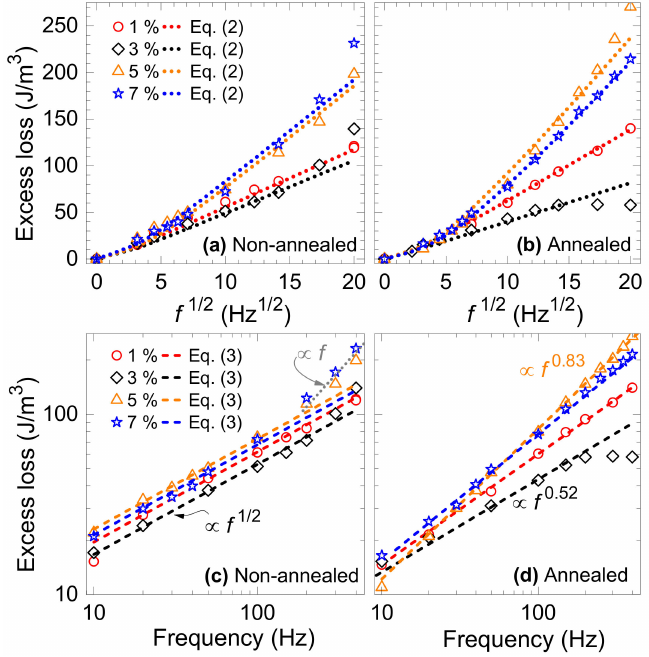
Figure 11. Excess loss in ( a , c ) non-annealed and in ( b , d ) annealed electrical steels of different cutting clearance. Experimentally obtained loss (points) are compared with its theoretical predictions represented by dotted lines calculated through Equation (2) in case of ( a , b ) and by short-dashed lines through Equation (3) in case of ( c , d